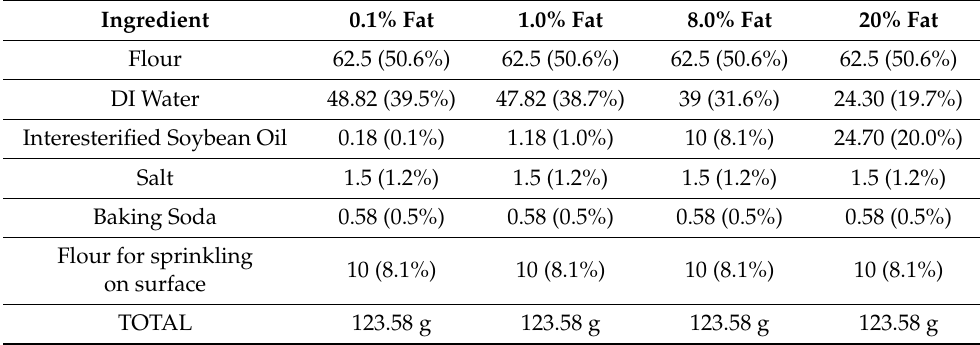
Figure 1. Flow diagram of cracker baking. Insert: whole crackers. Table 1. Ingredients used for cracker baking